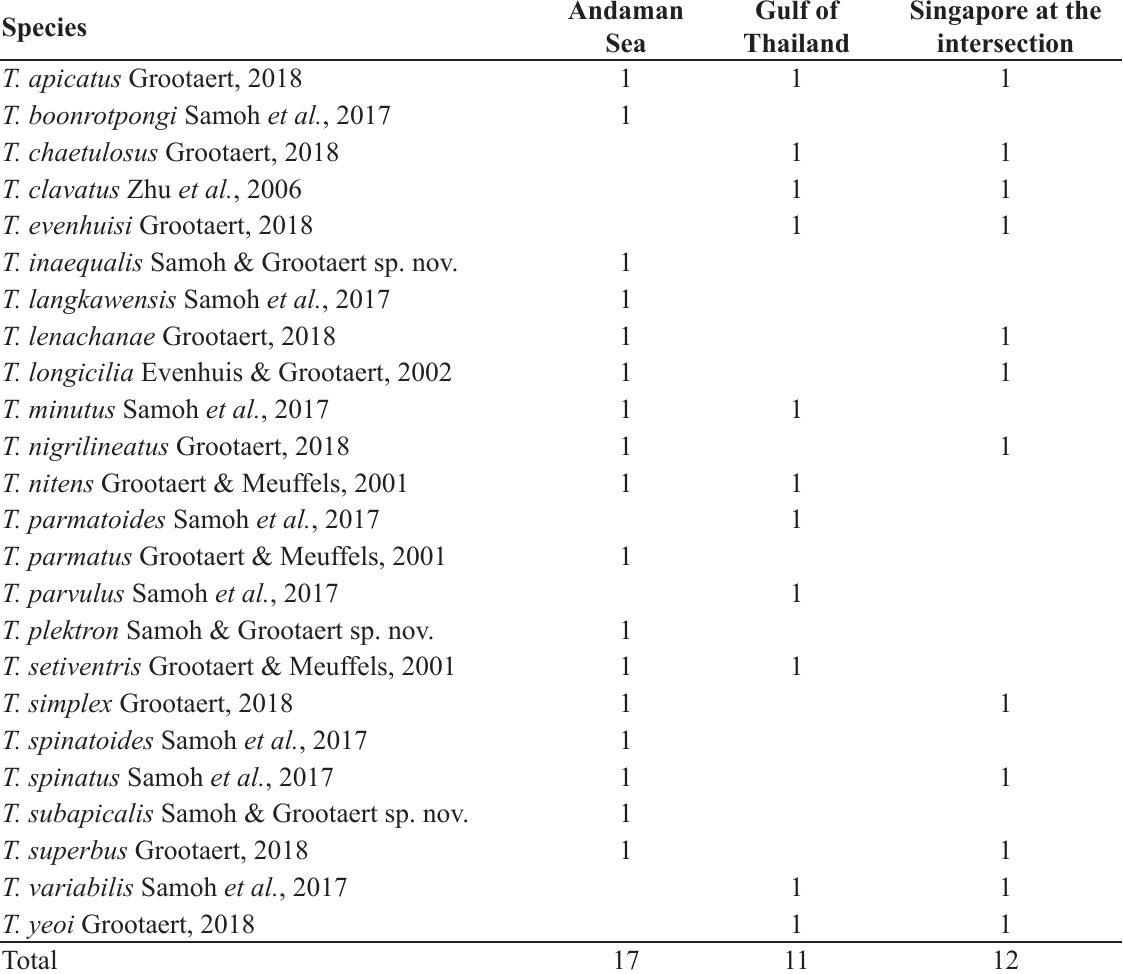
Table 1. Thinophilus Wahlberg, 1844 occurring in peninsular Thailand. Comparison of the species along the Andaman Sea coast, the Gulf of Thailand, and the intersection of both seas at the level of